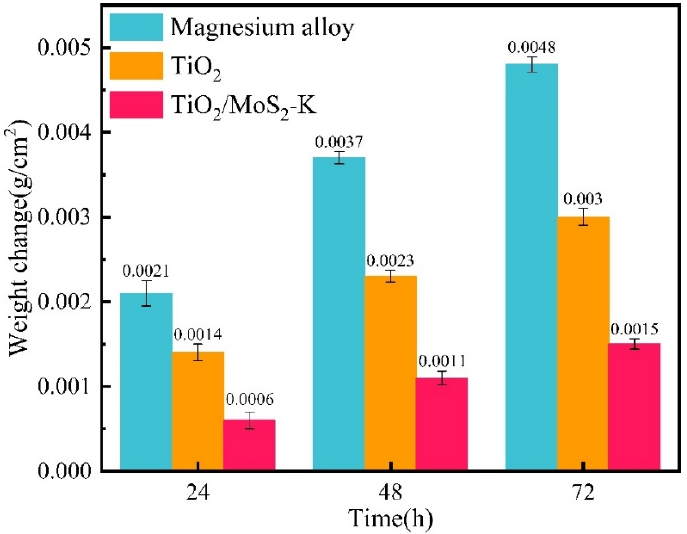
Figure 10. Salt spray corrosion weight gain diagram.